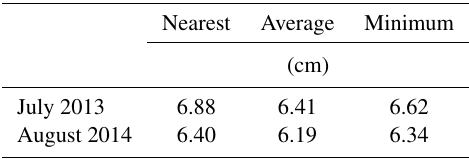
Table 2. Root mean square error (RMSE) between the phodar- derived DSM and RTK DGPS elevation measurements based on the three schemes: nearest neighbor, average, and minimum eleva- tion within the 0.5m